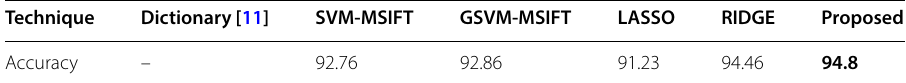
Table 6 Accuracy for different classifiers worked on ORL database Technique